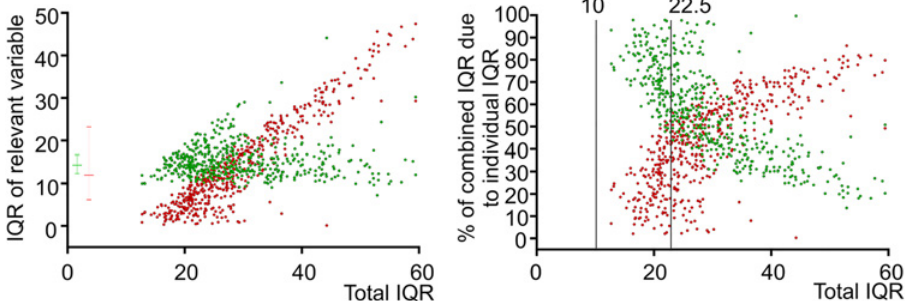
Fig 1. The interquartile range of bradykinesia and dyskinesia scores. A. The BKS IQR (green dots) and DKS IQR (green dots) for each patient was plotted against the IQR C . The error bars adjacent to the Y axis represent the median and interquartile range of the BKS IQR (green lines) and DKS IQR (red lines) shown in this figure. B. The BKS IQR (green dots) and DKS IQR (green dots) for each patient was expressed as a percentage of the IQR C and plotted against the IQR C . Note that there no IQR C values are less than 10. Note that the vertical line at IQR C = 22.5, where the BKS IQR contributes to about 60% to the IQR C , corresponds to the point that separates fluctuators and non fluctuators in Fig 2, showing that both BKS IQR and DKS IQR contribute significantly to the IQR C at this point.